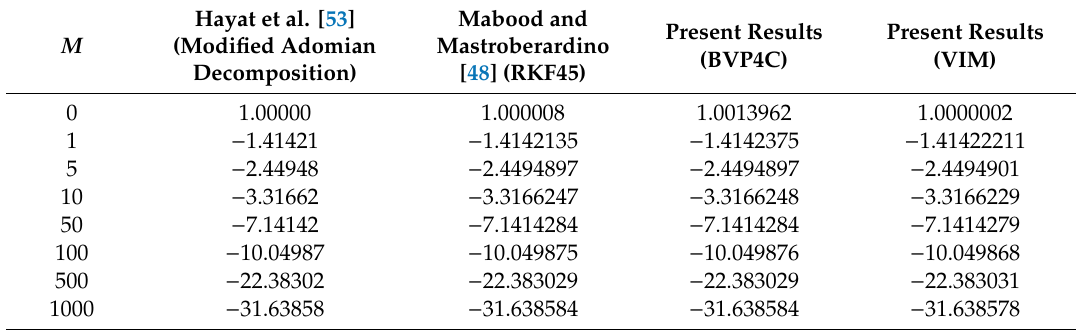
Table 1. Comparison of skin friction f (cid:48)(cid:48) ( 0 ) for di ff erent values of M when Pr = 1, Me = δ = γ = Nb